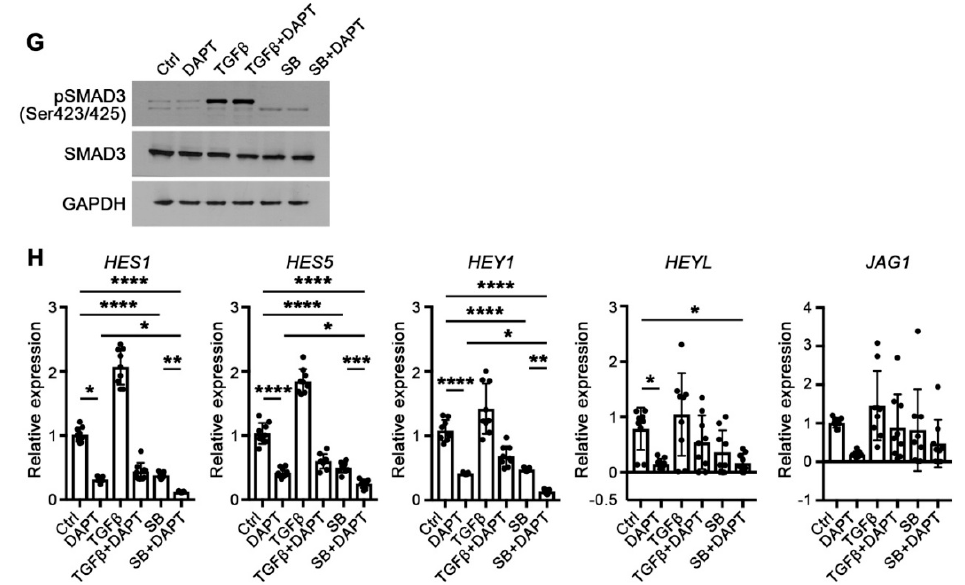
Figure 4. physiological role of TGF β and NOTCH in the myogenic process. ( A ) The proliferation of hPSC-derived myoblasts with or without TGFs (TGF β 1, TGF β 2, and TGF β 3). ( B ) The fusion index was calculated after treatment of TGFs for 7 days. ( C ) The fusion index of control or TGFs-treated myoblasts with SB-431542 and DAPT. ( D ) Gene expression level of NOTCH component factors was analyzed using an RNA sequencing database for myogenesis (www.myogenesis.net). ( E ) Gene expression level of downstream factors of NOTCH was analyzed using RNA sequencing database for myogenesis (www.myogenesis.net). ( F ) The expression level of genes under the co-regulation of TGF β and NOTCH was analyzed using an RNA sequencing database for myogenesis (www.myogenesis.net). ( G ) Immunoblotting for confirmation of SMAD3 activity by single or combinational treatment of DAPT with TGF β or SB-431542. ( H ) The transcription level of NOTCH-responsive genes by single or combinational treatment of DAPT with TGF β or SB-431542. * p < 0.05, ** p < 0.01, *** p < 0.001, **** p < 0.0001, ns = non significance, Unpaired t-test or One-way ANOVA.